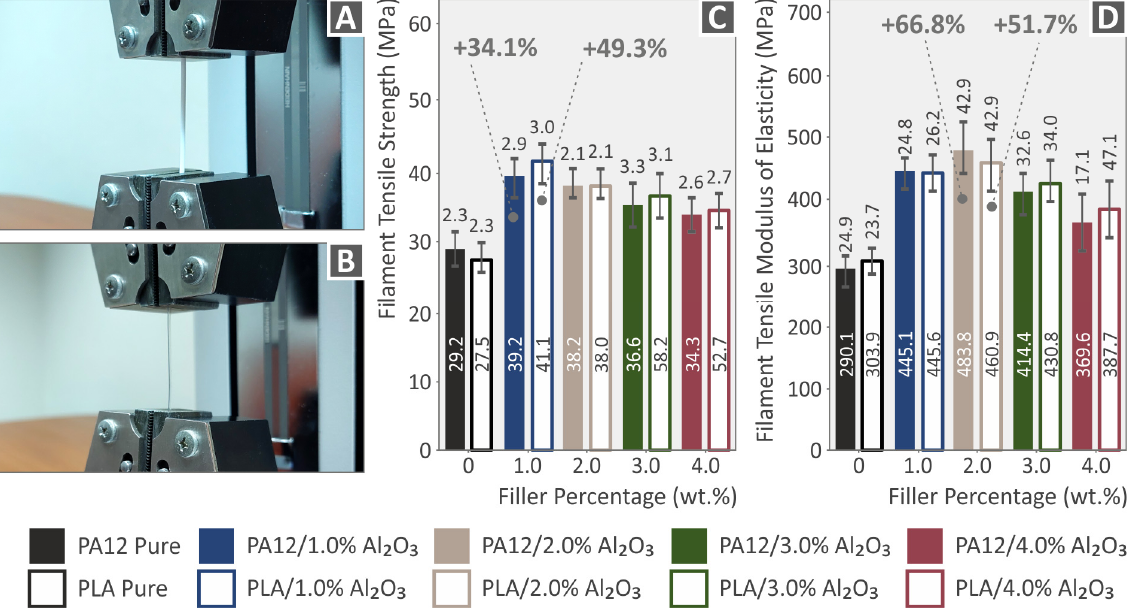
Figure 12. ( A , B ) Representative neat polymer and nanocomposite polymer filament under testing; ( C , D ) Tensile strength and tensile modulus of elasticity for 3DP PA12, PLA, and all nanocomposite filaments at 1.0, 2.0, 3.0, and 4.0 wt.% Al 2 O 3 filler loading. Legend shows which color corresponds